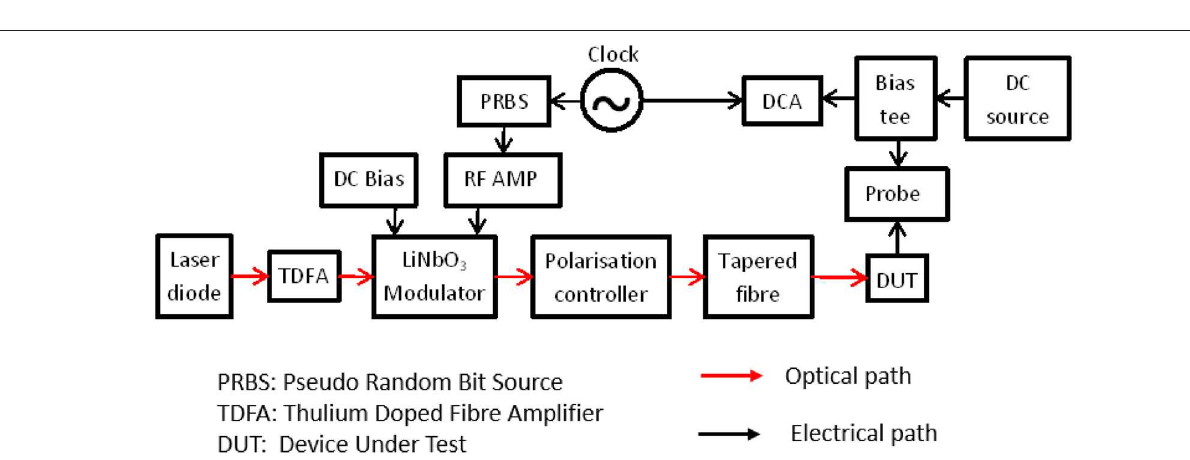
FIGURE 2 | A schematic of the experimental setup to obtain eye diagrams at 2 µ m.